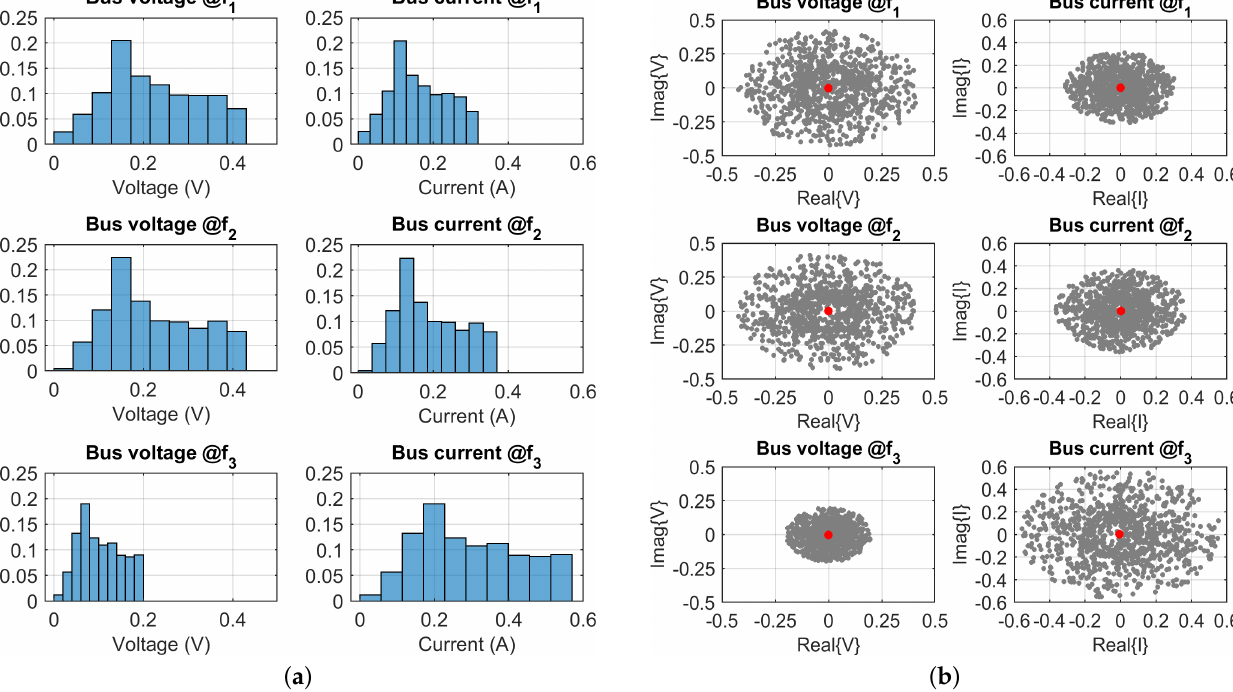
Figure 11. ( a , b ) Results of MCM simulations for the three-converter network with a larger number of MCM trials (1000); converters are separated by 100m of line cable